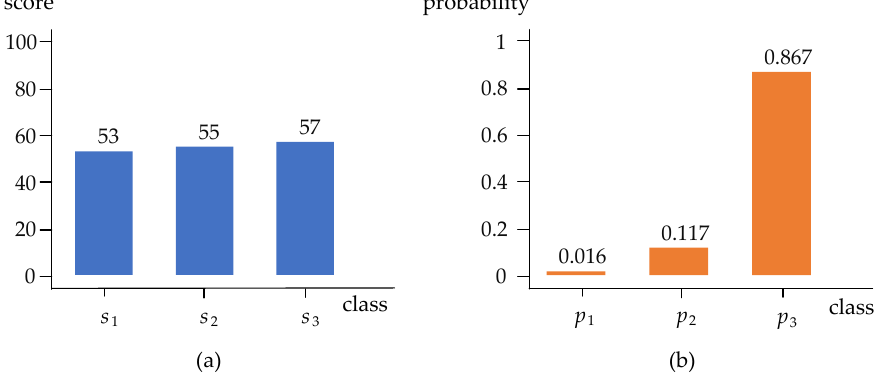
Figure 4. The “over-confidence” caused by softmax: ( a ) are the probable scores of three categories after feature extraction and ( b ) are their corresponding probabilities mapped by softmax.